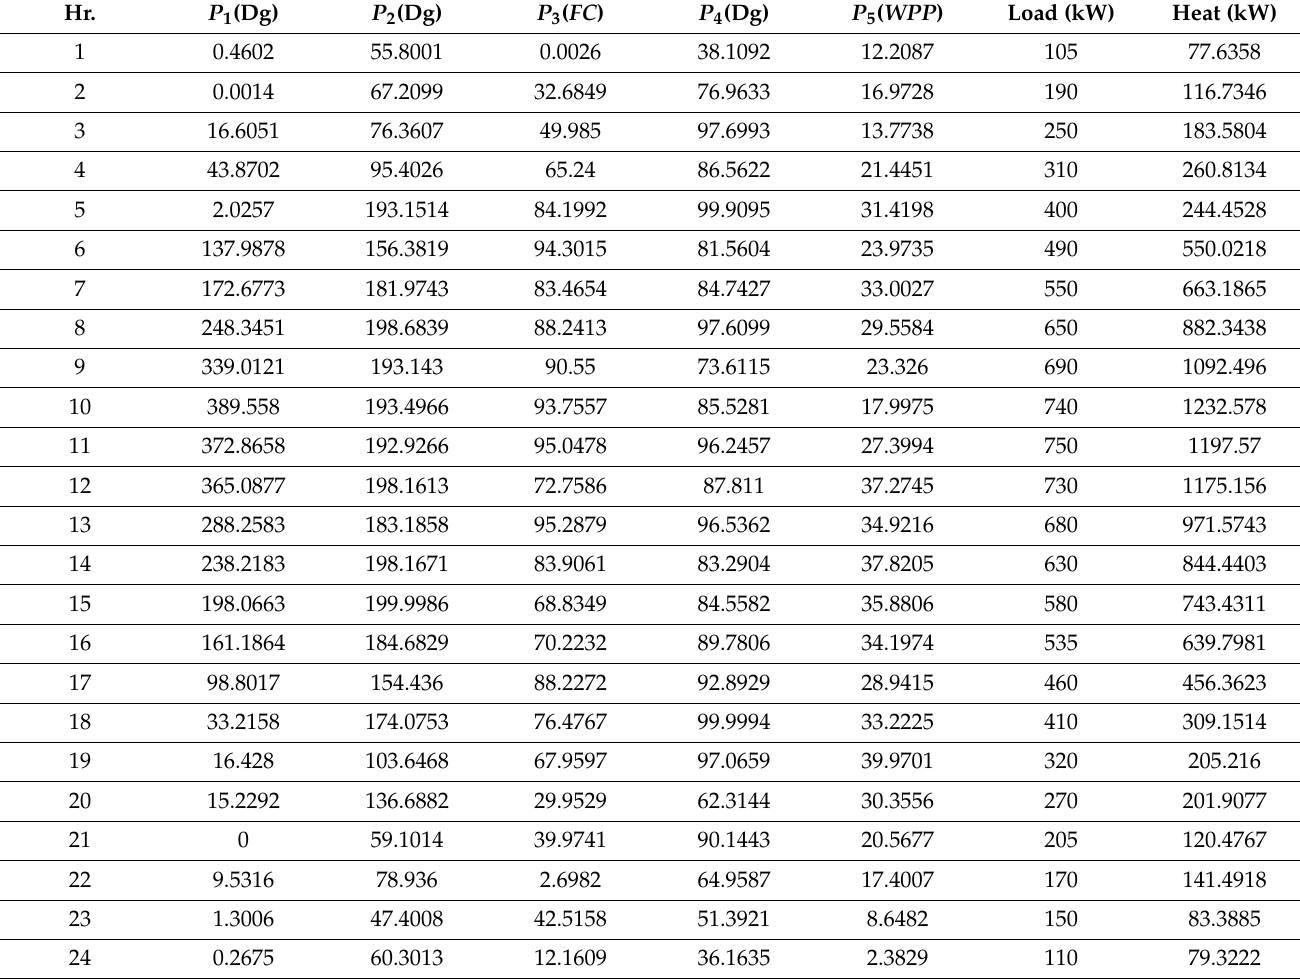
Table 10. Optimal generation scheduling for MCHPEED with REI under